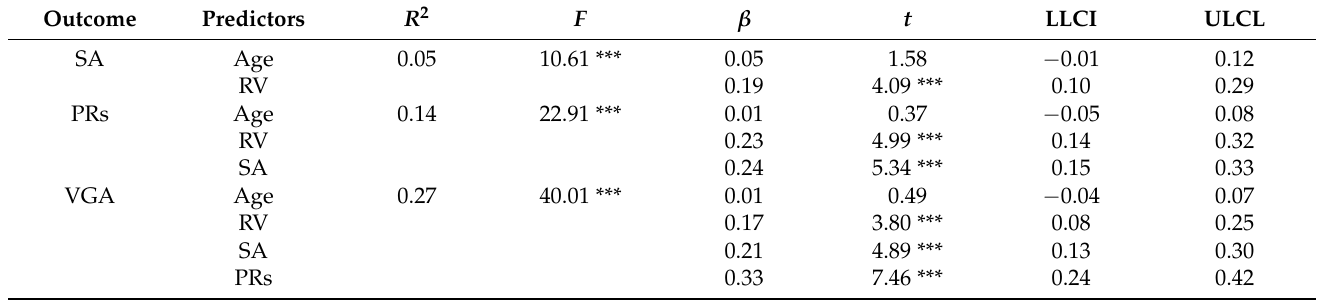
Table 2. Testing the serial mediation effect of relational victimization and video game addiction.